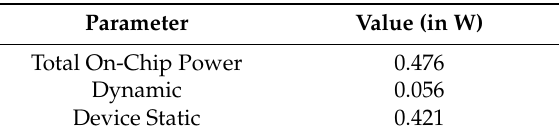
Table 3. Power results